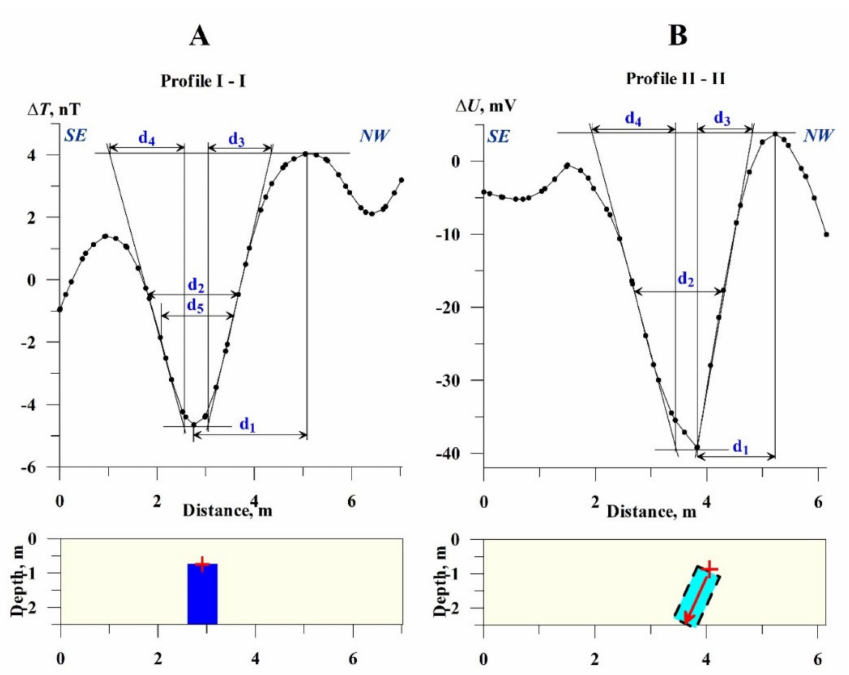
Figure 14. Quantitative analysis of magnetic ( A ) and self-potential ( B ) anomalies in the site of Halutza (southern Israel). The red cross in both models indicates position of the center of the upper edge, and the red arrow (in B) shows direction of self-polarization vector.